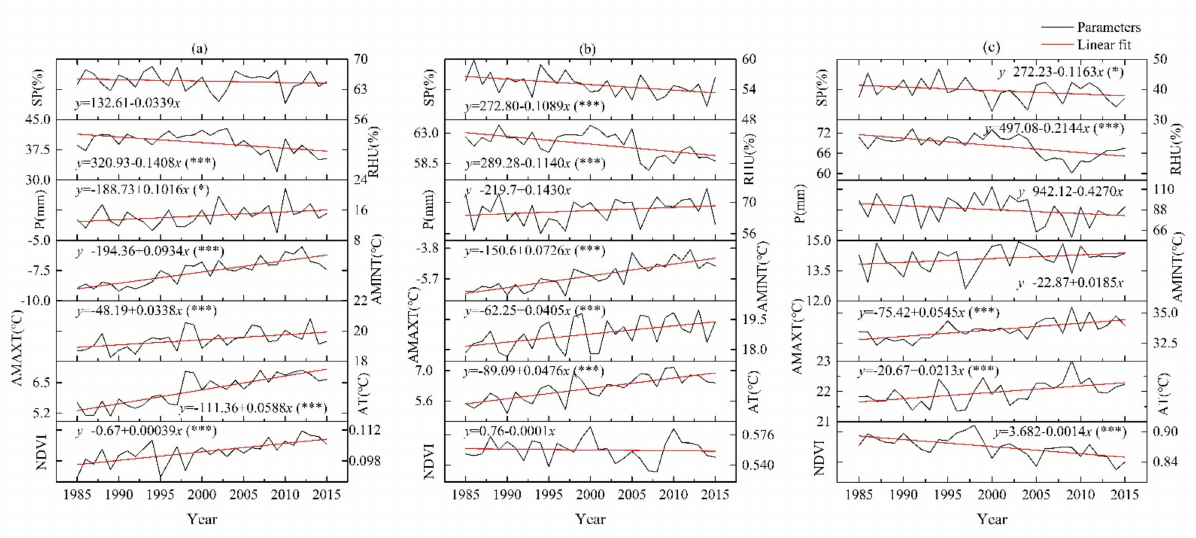
Figure 7. The trends in NDVI during the growing season for the three types of vegetation ( a ): alpine desert; ( b ): alpine meadow; ( c ): broadleaf evergreen forest) and the corresponding regional climate factors from 1985 to 2015. The average temperature, average maximum temperature, average minimum temperature, precipitation, relative humidity, and sunshine percentage are denoted as AT, AMAXT, AMINT, P, RHU, and SP, respectively. The *, **, *** indicate the slope is significantly different from zero (no trend) at the 0.1, 0.05, 0.01 level,